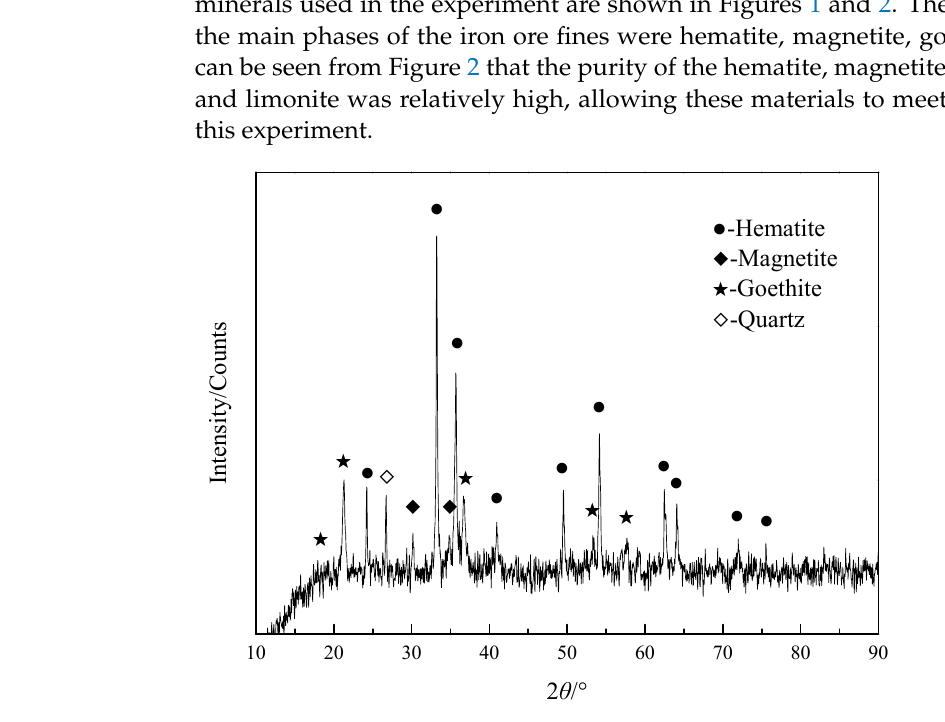
Figure 1. XRD analysis of sintering iron ore fines.